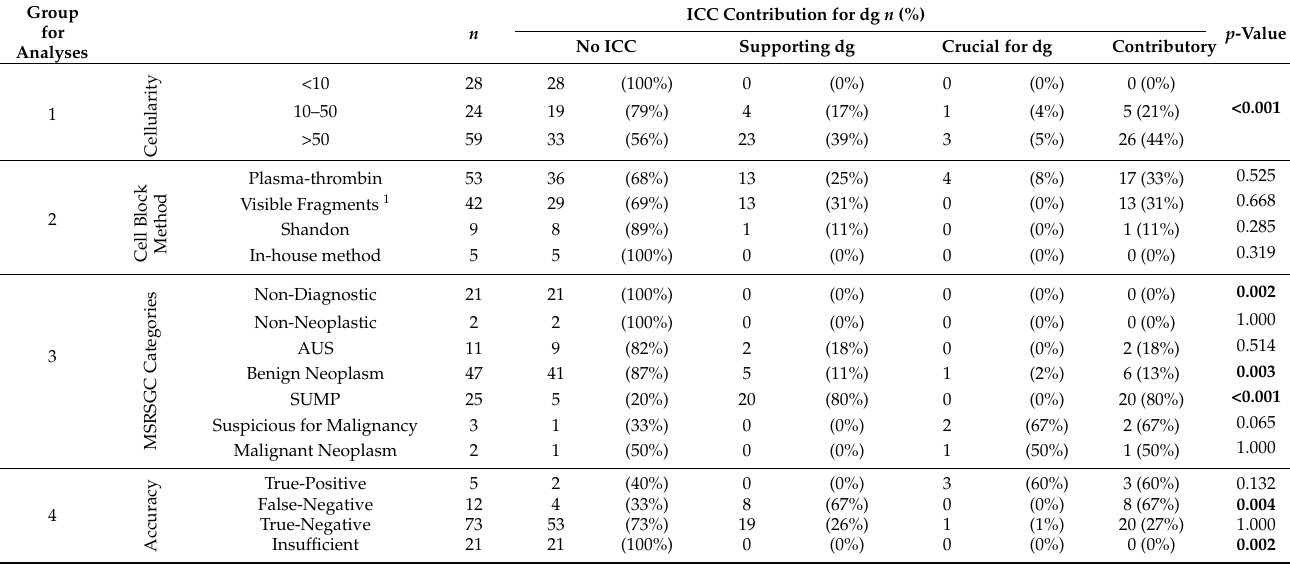
Table 5. Contribution of ICC for Cytological Diagnosis was analyzed at four different levels: CB cellularity, CB method, MSRSGC categories and accuracy, which were compared with the CBs’ contributory role in final cytological diagnosis. Group for n Analyses